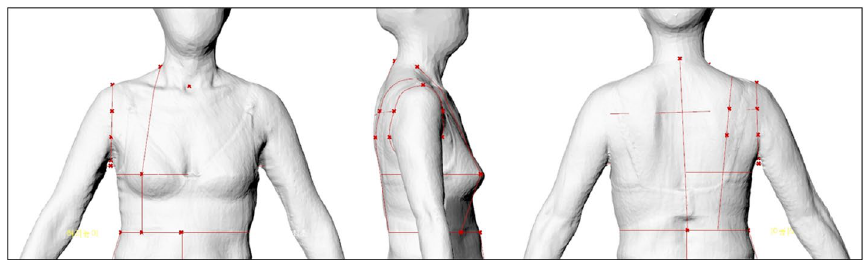
Fig. 15 Results of automatic search for